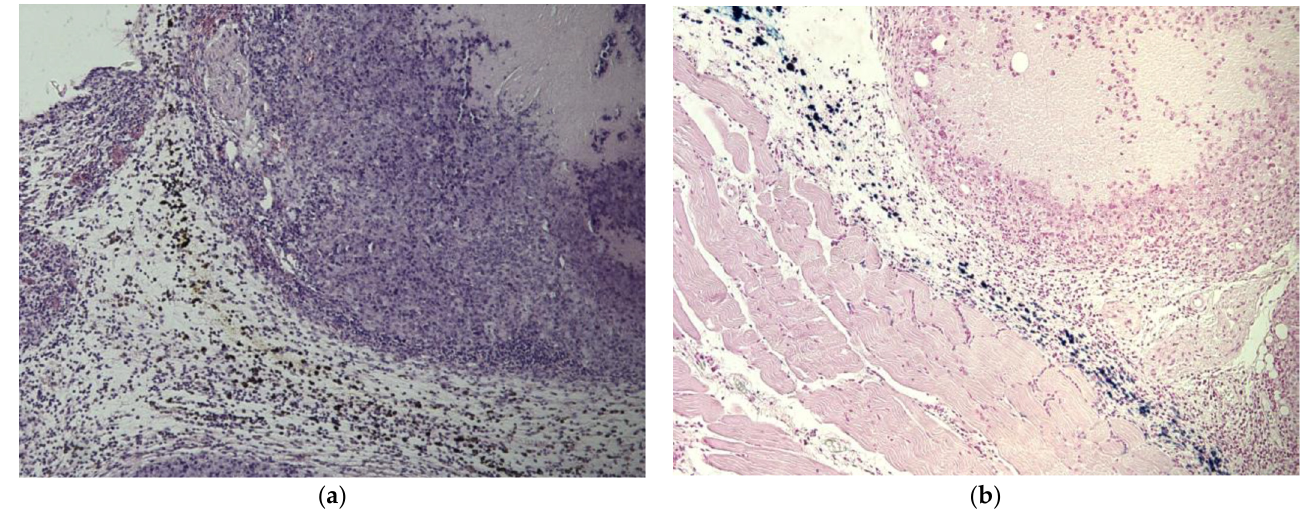
Figure 7. These histological sections demonstrate significant mNP accumulation in the peritumoral ( a , b ) and the intratumoral region ( a ) following EcPHL treatment and mNP administration (6 h prior to sampling). H&E staining ( a ), Perl’s Prussian blue staining ( b ). Magnification: ×100.